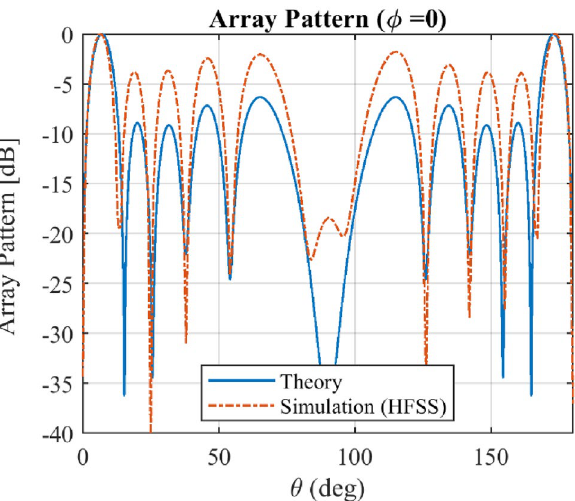
Figure 12. The total radiation pattern of array at φ = 0 including the mutual coupling effect considered in simulation study by